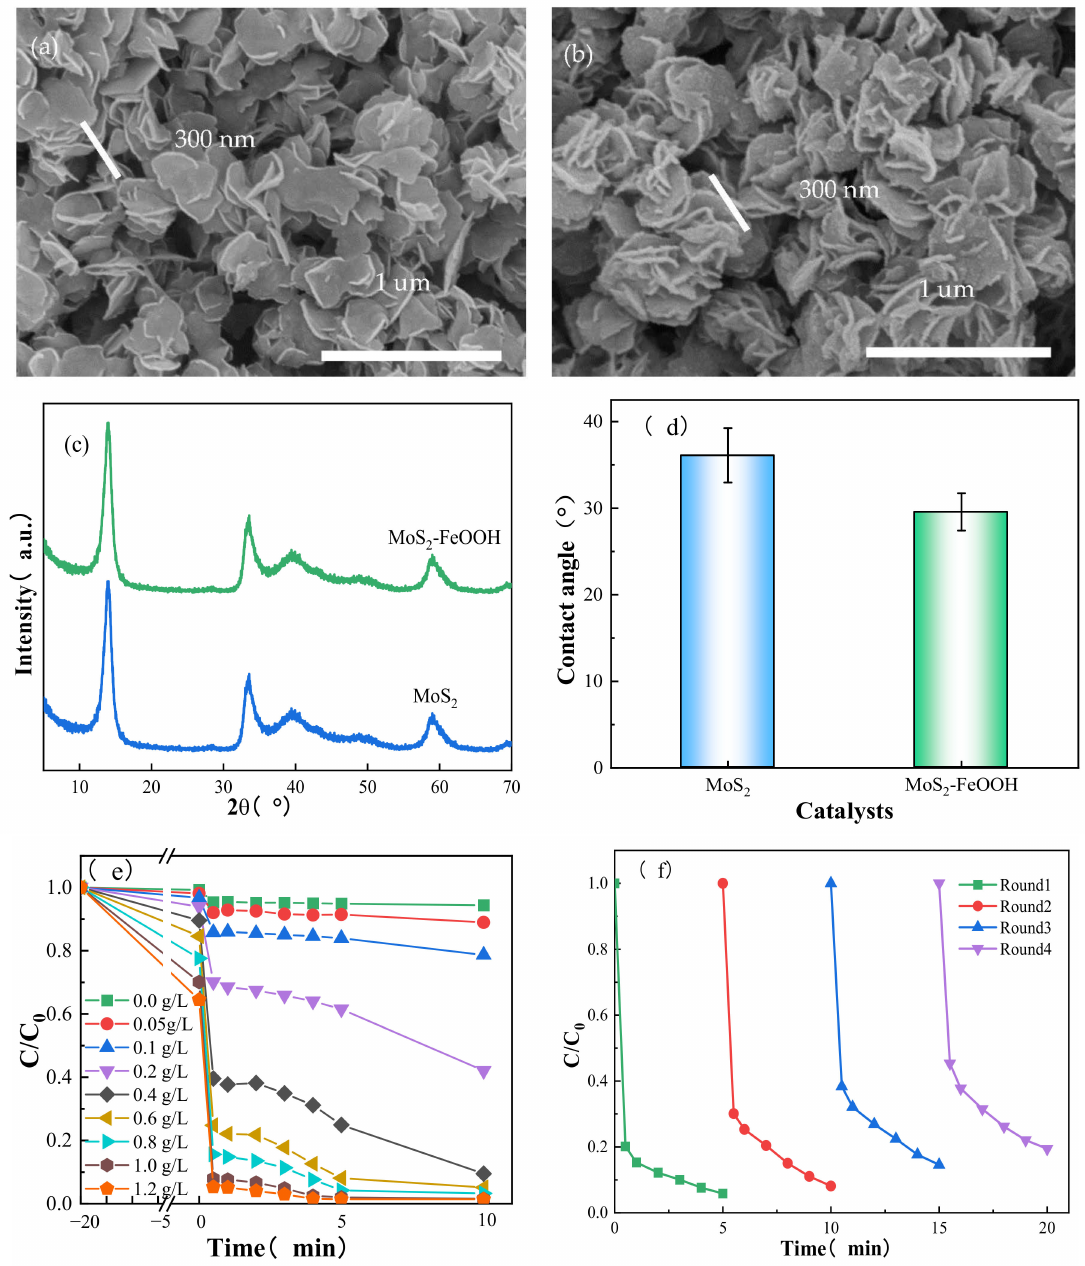
Figure 2. Characterization of the catalytic nanoparticles. ( a ) SEM image of MoS 2 nanoparticles; ( b ) SEM image of MoS 2 -FeOOH nanoparticles; ( c ) XRD of MoS 2 and MoS 2 -FeOOH nanoparticles; ( d ) water contact angle of MoS 2 and MoS 2 -FeOOH nanoparticles; ( e ) MB degradation rate with different MoS 2 -FeOOH nanoparticles content; ( f ) cyclic degradation of MoS 2 -FeOOH